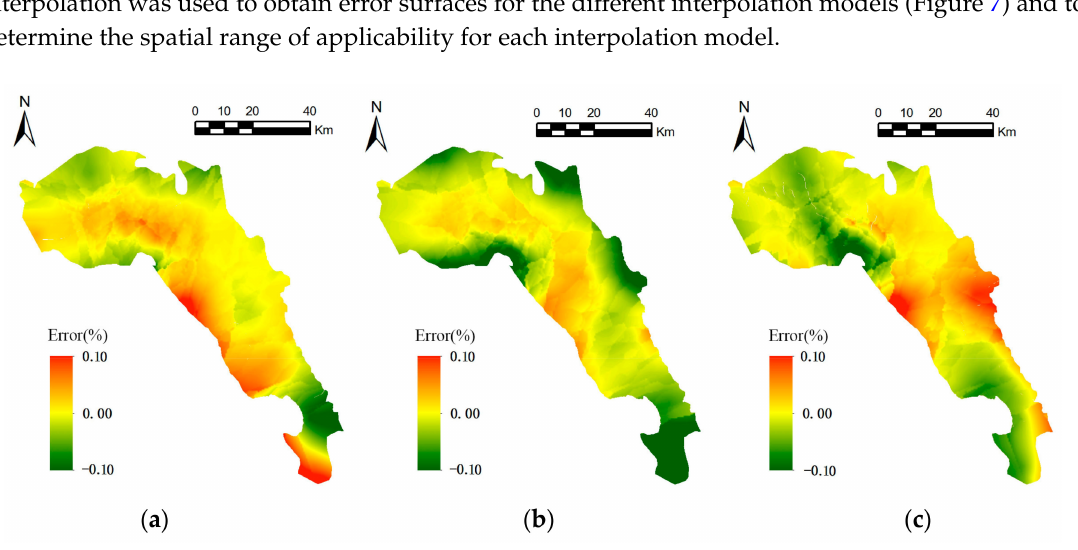
Figure 7. Error surfaces of base interpolation models: ( a ) land use; ( b ) geology; ( c ) soil type.